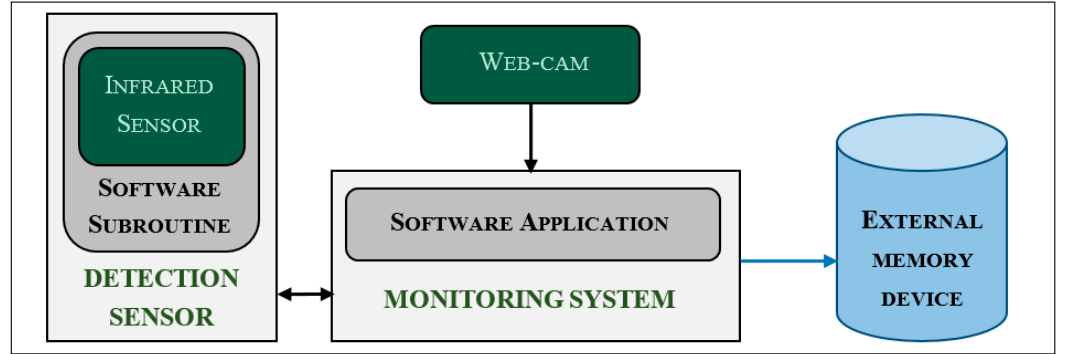
Figure 1. Block schema of the experimental monitoring system.